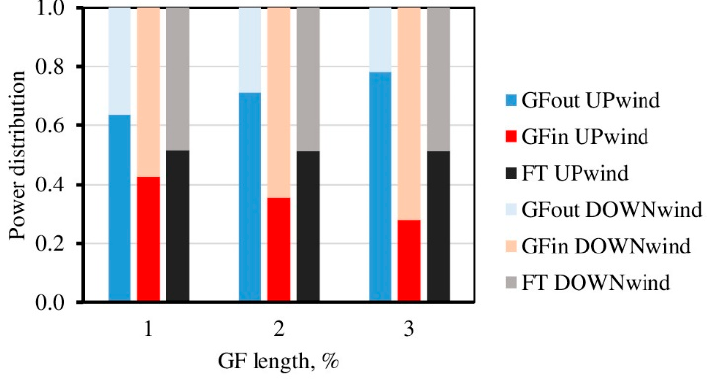
Figure 14. Gurney flap length and configuration influence on the power extraction distribution.